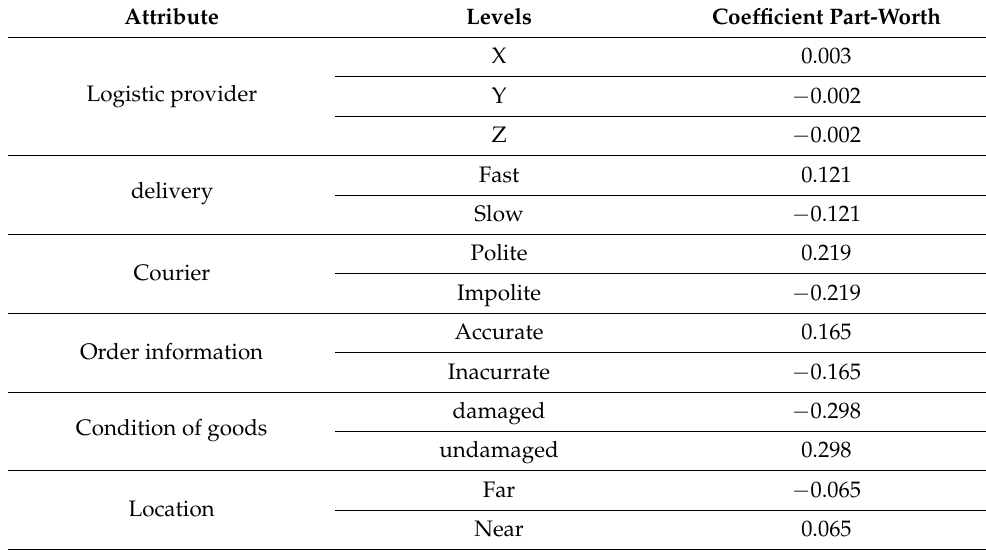
Table 6. Part-worth coefficient result.